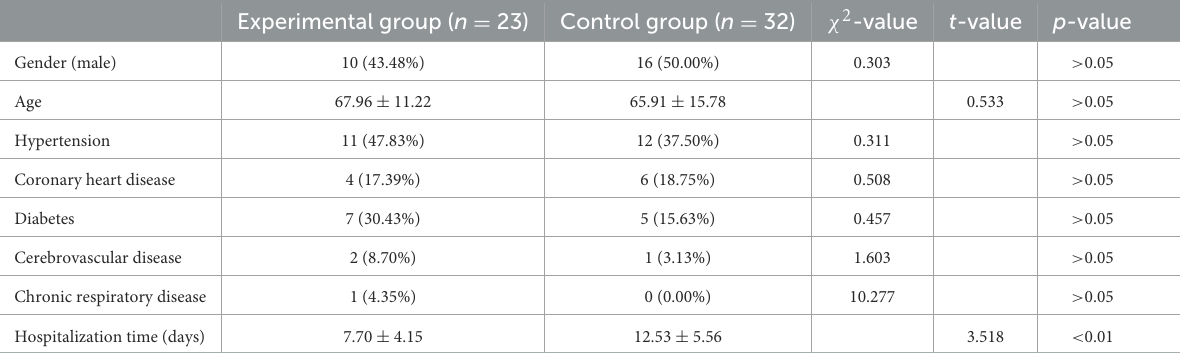
TABLE 1 Statistical analysis of difference between the two groups.